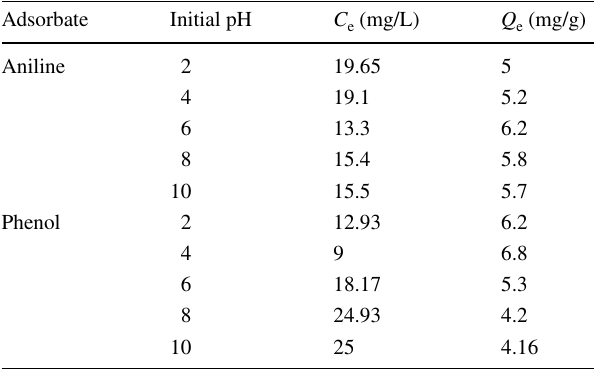
Fig. 2 Effect of pH on removal efficiency of pollutants by bentonite (contact time = 60 min, dosage = 0.6 g/L, aniline and phenol concen- tration = 100 mg/L) Table 2 Effect of initial pH on aniline and phenol removal by ben- tonite